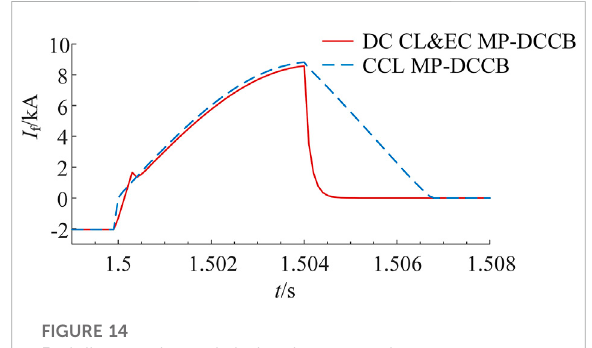
FIGURE 14 Fault line opening and closing time